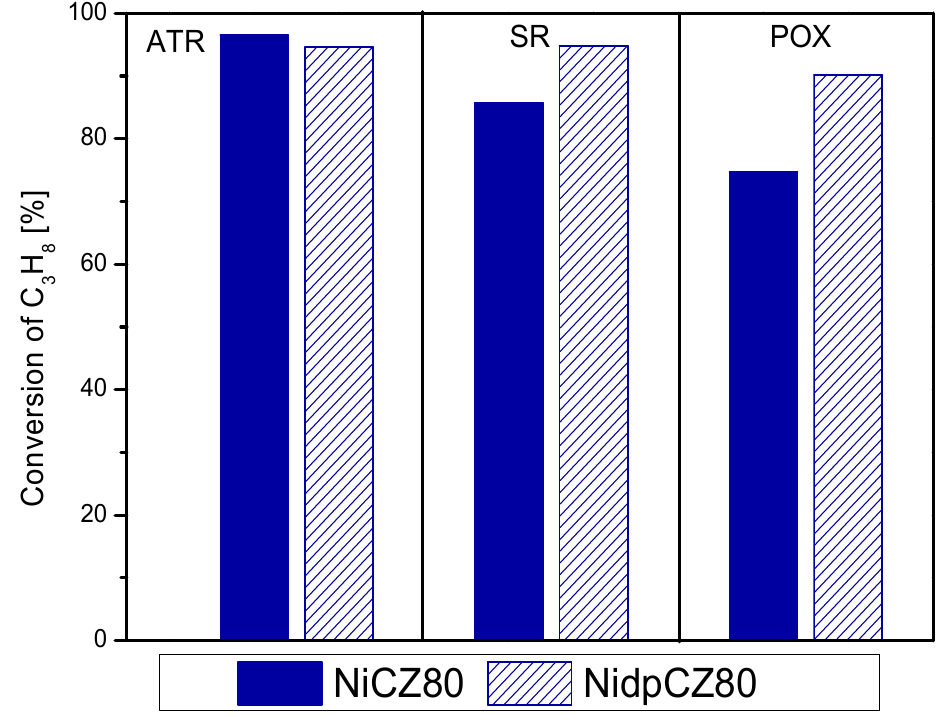
Figure 9. Conversion of methane CH 4 for NiCZ80 and NidpCZ80 under ATR, SR, and POX conditions at T = 800 °C GSVH = 120,000 h − 1 .